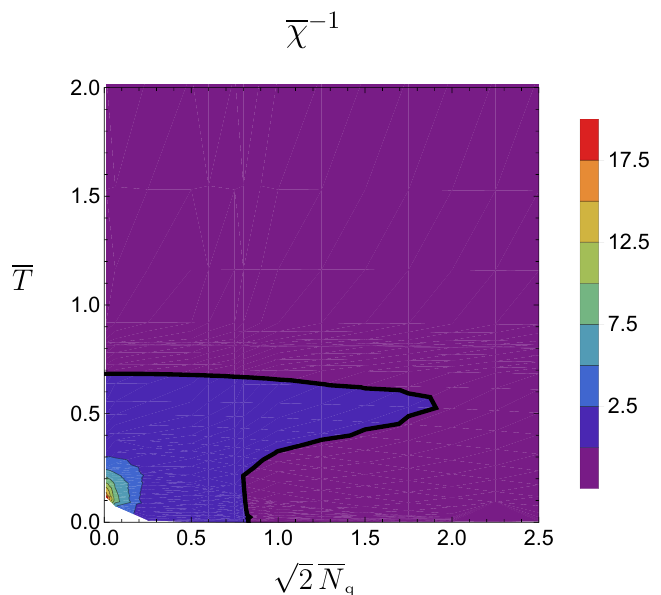
Figure 16. Contour plot of the inverse charge susceptibility. The thick, black, continuous curve indicates the locus where (cid:31) (cid:0) 1 changes